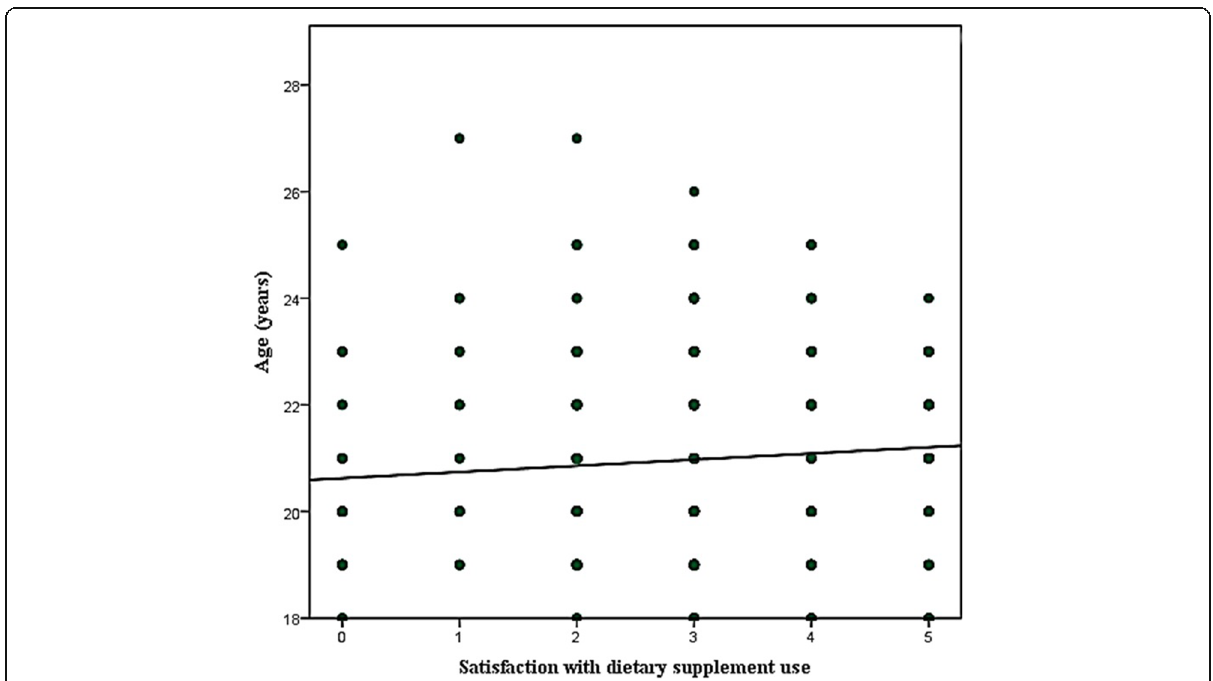
Fig. 1 Correlation of student age with satisfaction score